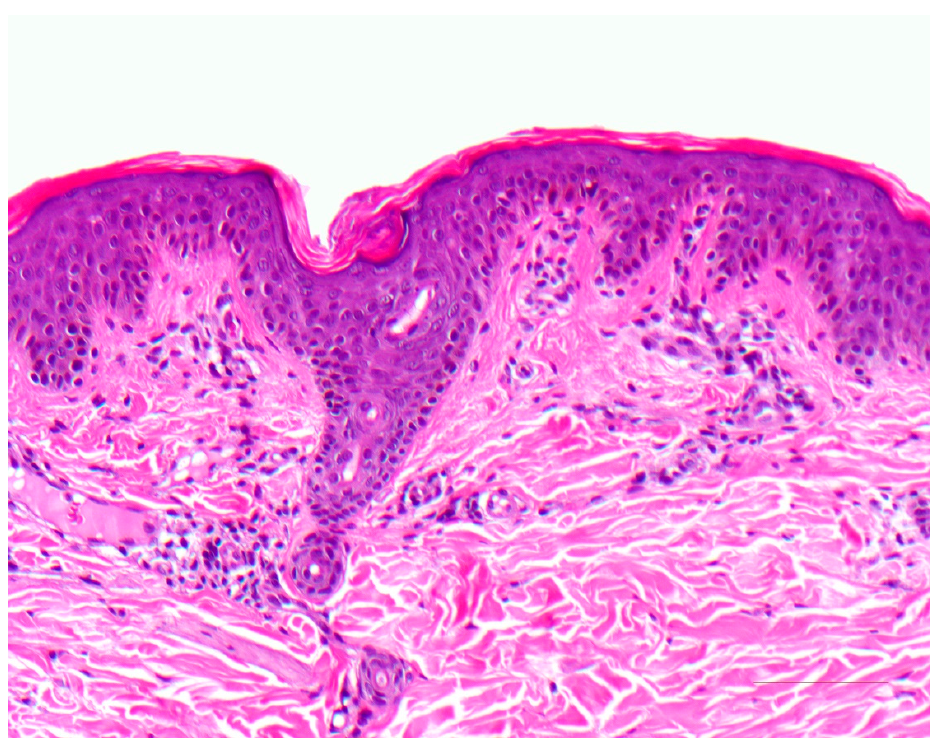
Figure 2. Ichthyosis vulgaris. Note the absent stratum granulosum and mild compact orthohyperkeratosis. Marked hyperkeratosis of the opening of the acrosyringium. Inflammatory infiltrates are almost absent. HE stain, bar = 100 µm.